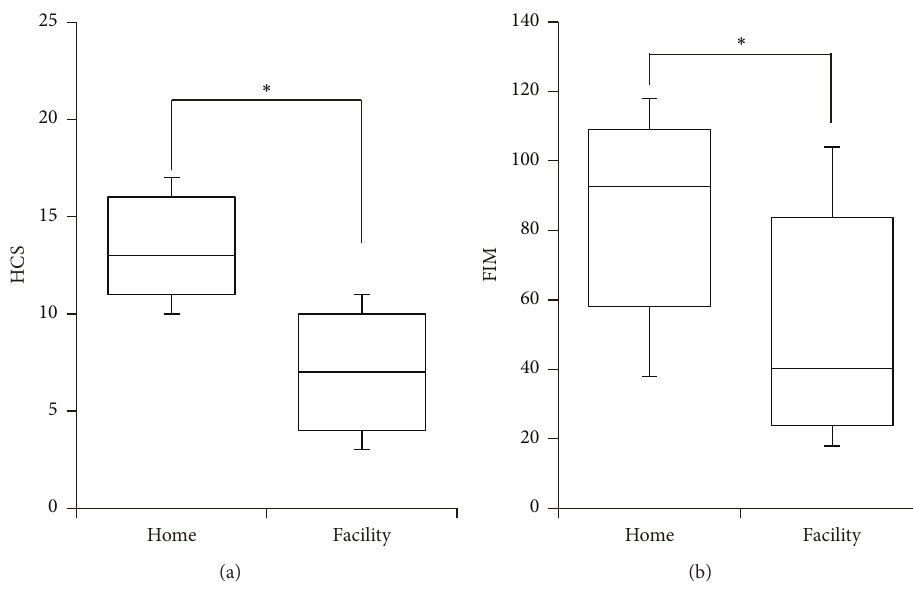
Figure 1: Boxplots of the home care score (HCS) (a) and functional independence measure (FIM) score (b). The middle horizontal lines indicate the median; the top and bottom lines of the box indicate the tertiary and first quartiles, respectively; and the top and bottom vertical lines indicate 90% and 10%, respectively. Asterisks indicate significant differences. Table 1: Characteristics of the subjects.